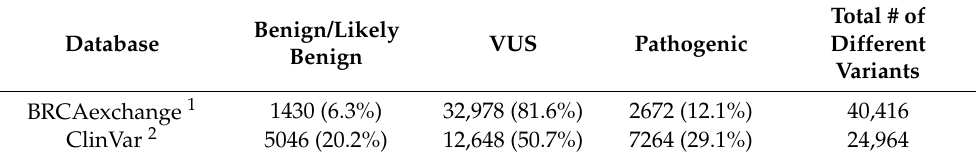
Table 1. The number of different BRCA1/BRCA2 variants reported in public